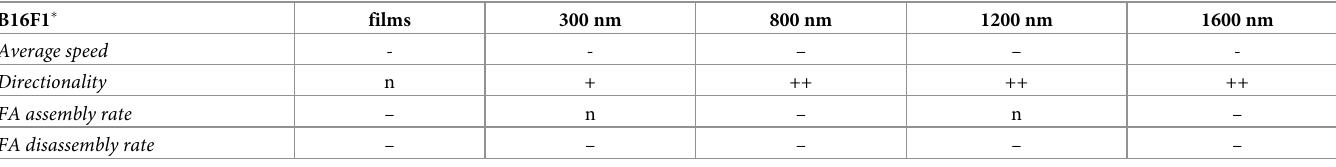
Table 2. Summary of the impact of microgels on the behavior of B16F1 cells.